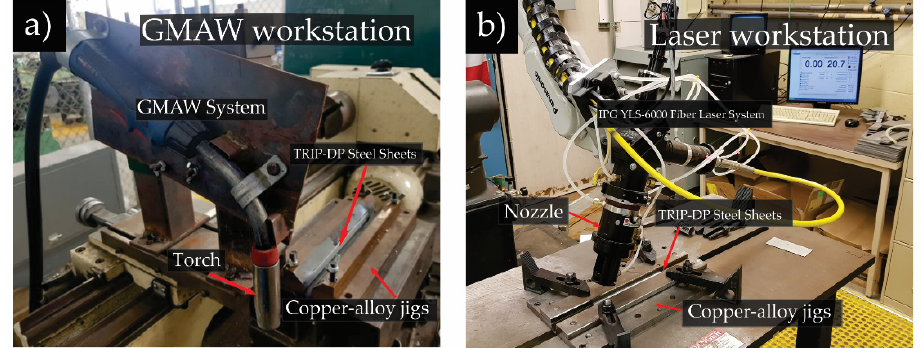
Figure 2. Experimental setup for ( a ) GMAW and ( b ) LBW.